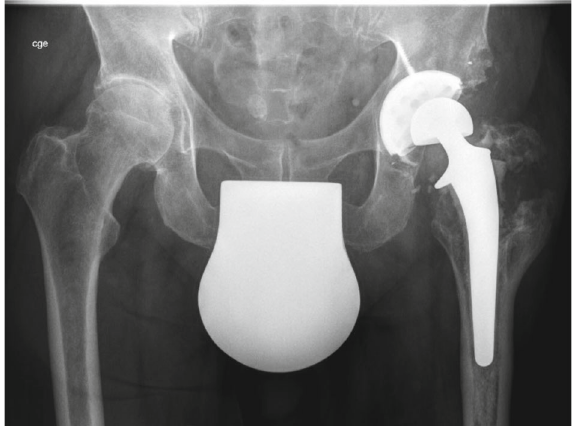
Figure 3: X-ray prior to the third revision surgery (2020).